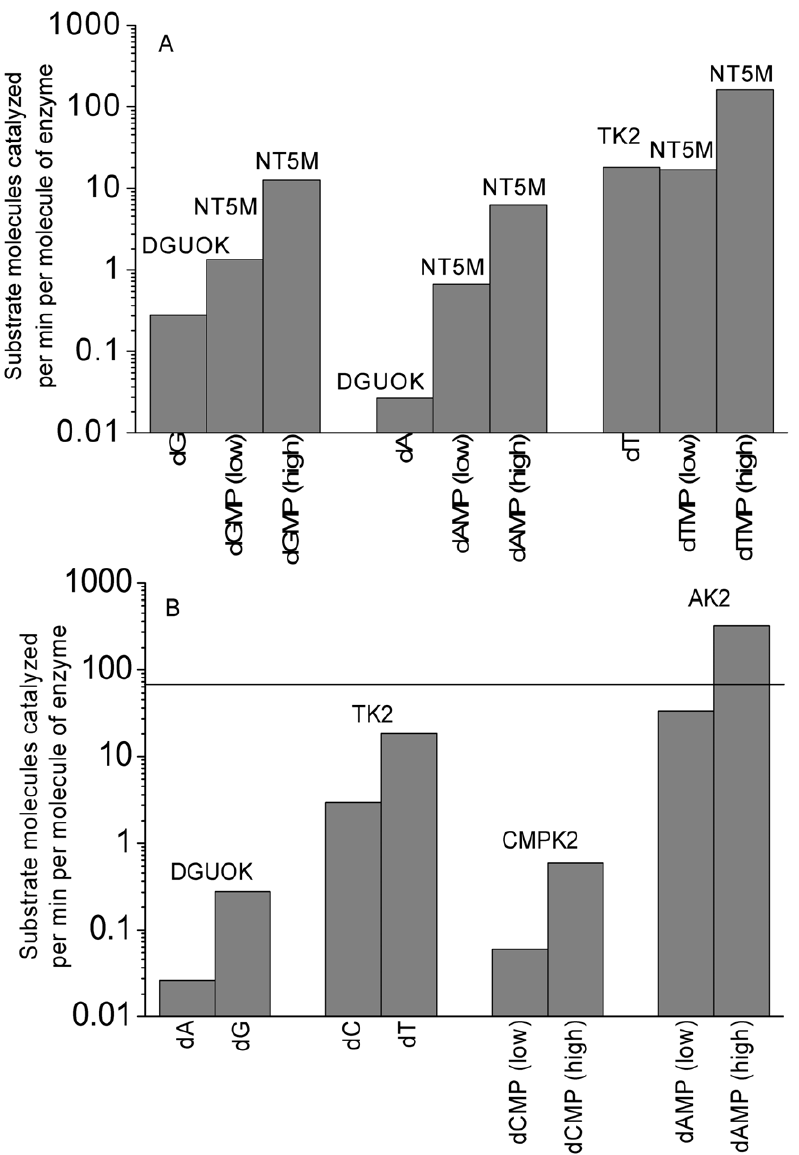
Figure 5. Effective velocities of some of the reactions of mitochondrial nucleotide metabolism. ( A ) Effective velocities (number of substrate molecules catalyzed per minute per enzyme molecule) of nucleoside kinase reactions versus NT5M reactions. Theoretical maximum velocities of NT5M reverse reactions are many-fold higher than the maximum velocities from nucleoside kinases. ( B ) A comparison of the effective velocities for deoxynucleotide substrates for enzymes of the mitochondrial salvage pathway. The horizontal reference line shows the number of nucleotides (approximately 69) of each triphosphate needed per minute on average to complete mtDNA replication in two hours.